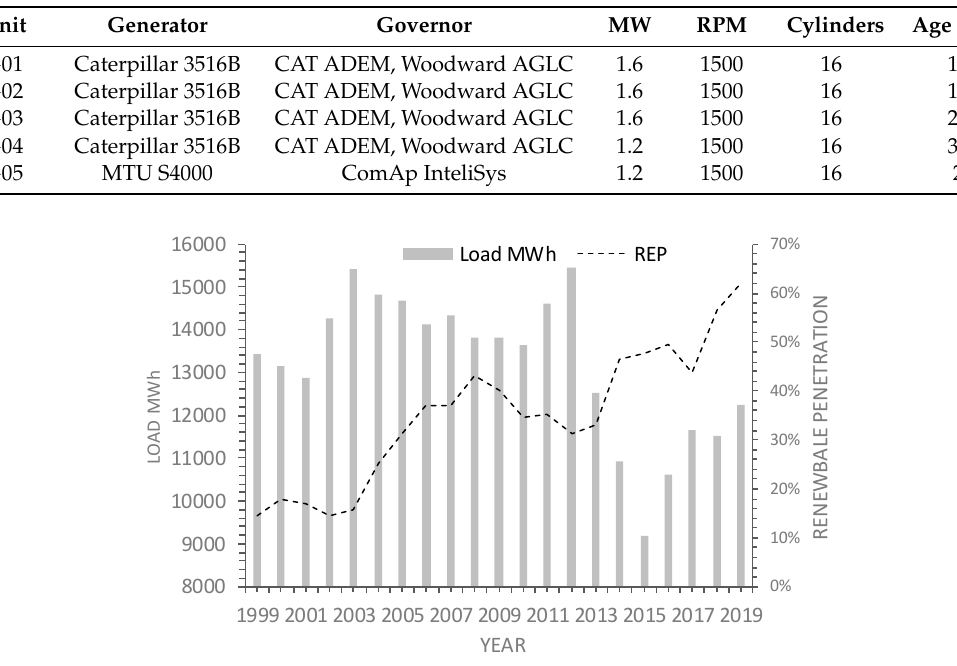
Table 3. King Island Currie Power Station generation.